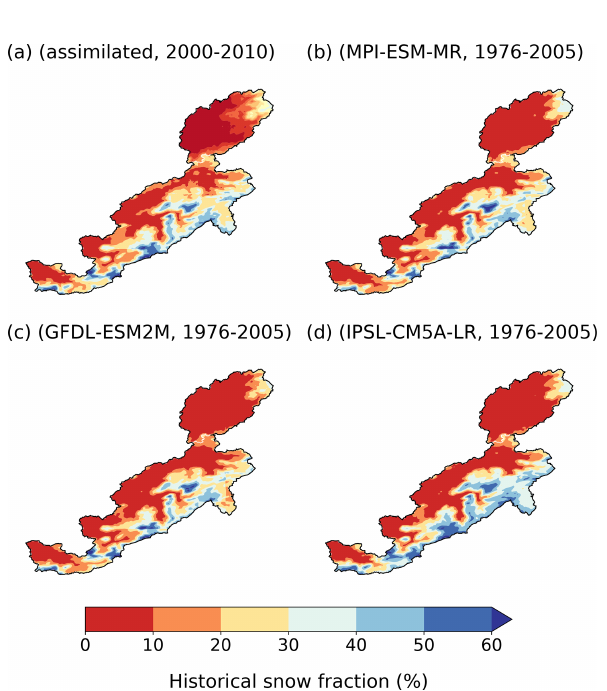
Figure A1. Snow fraction of annual precipitation in (a) the assim- ilated run of Tuel et al. (2020) (2000–2010), and (b–d) the histori- cal (1976–2005) runs of each of the three selected GCMs.